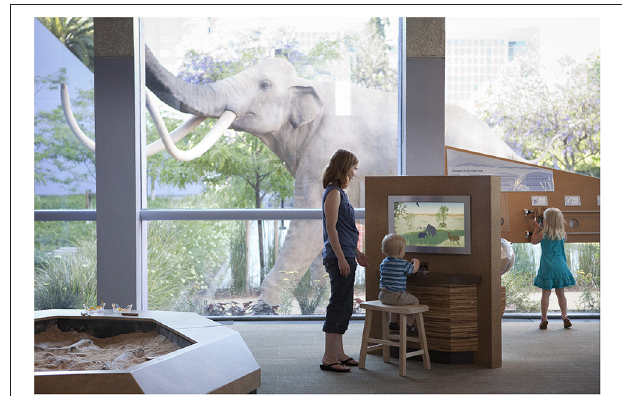
FIGURE 1 | Child seated at Spin Browser exhibit in Mammoth Discovery! exhibition at Children’s Discovery Museum of San Jose. The full-scale mammoth replica is visible outside the window and one of the Dig Pit exhibits is visible at lower